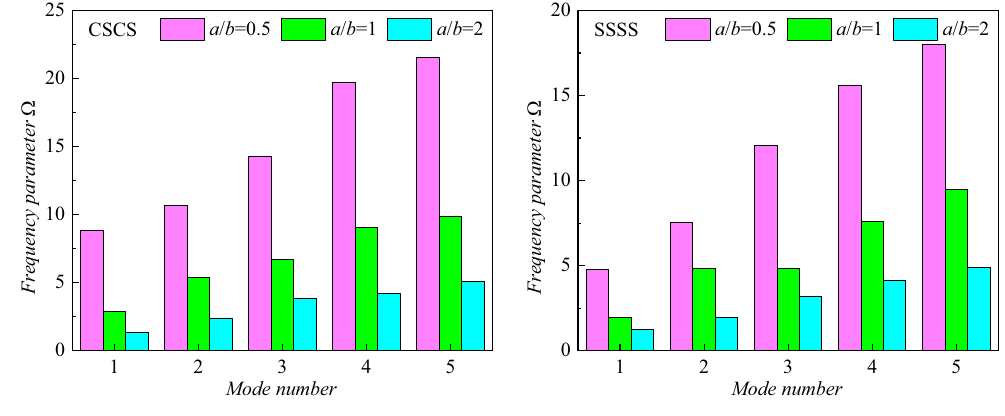
Figure 8: Frequency parameters Ω of rectangular plate with di ff erent a / b ratio.